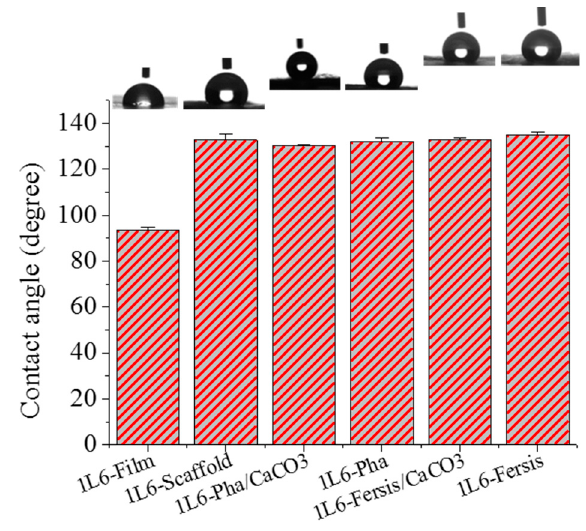
Figure 10. Contact angles for 1L6 films (used as control), unloaded electrospun 1L6 scaffolds and scaffolds loaded with Phagestaph and Fersis.